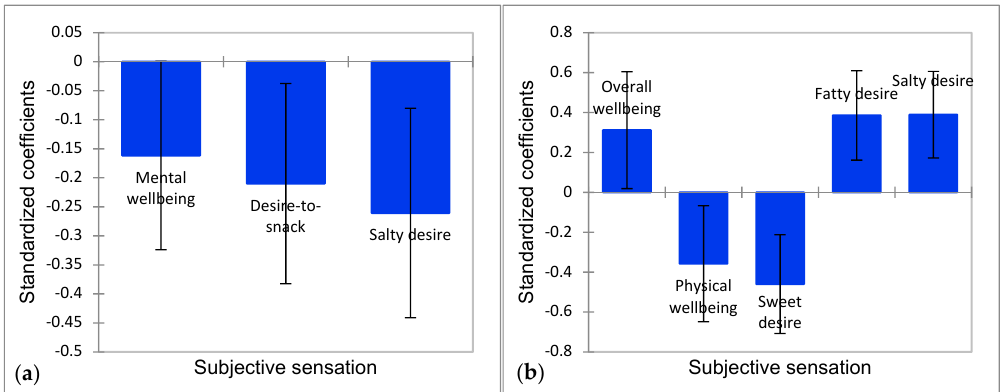
Figure 4. Significant explanatory sensations for ( a ) grapes choice and ( b ) potato chips choice depicting standardized coefficient values including 95% confidence intervals.